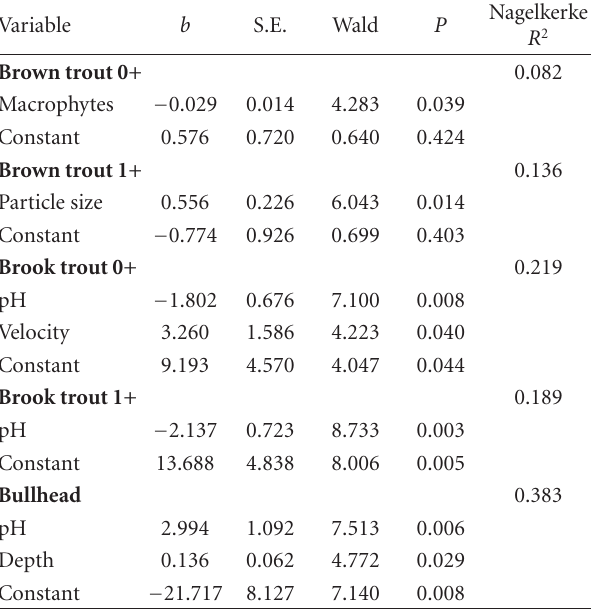
Table 6: Results of logistic regression with forward selection for the occurrence of brown trout, brook trout, and bullhead in relation to environmental factors in 2004. Separate analyses were performed for 0+ and 1+